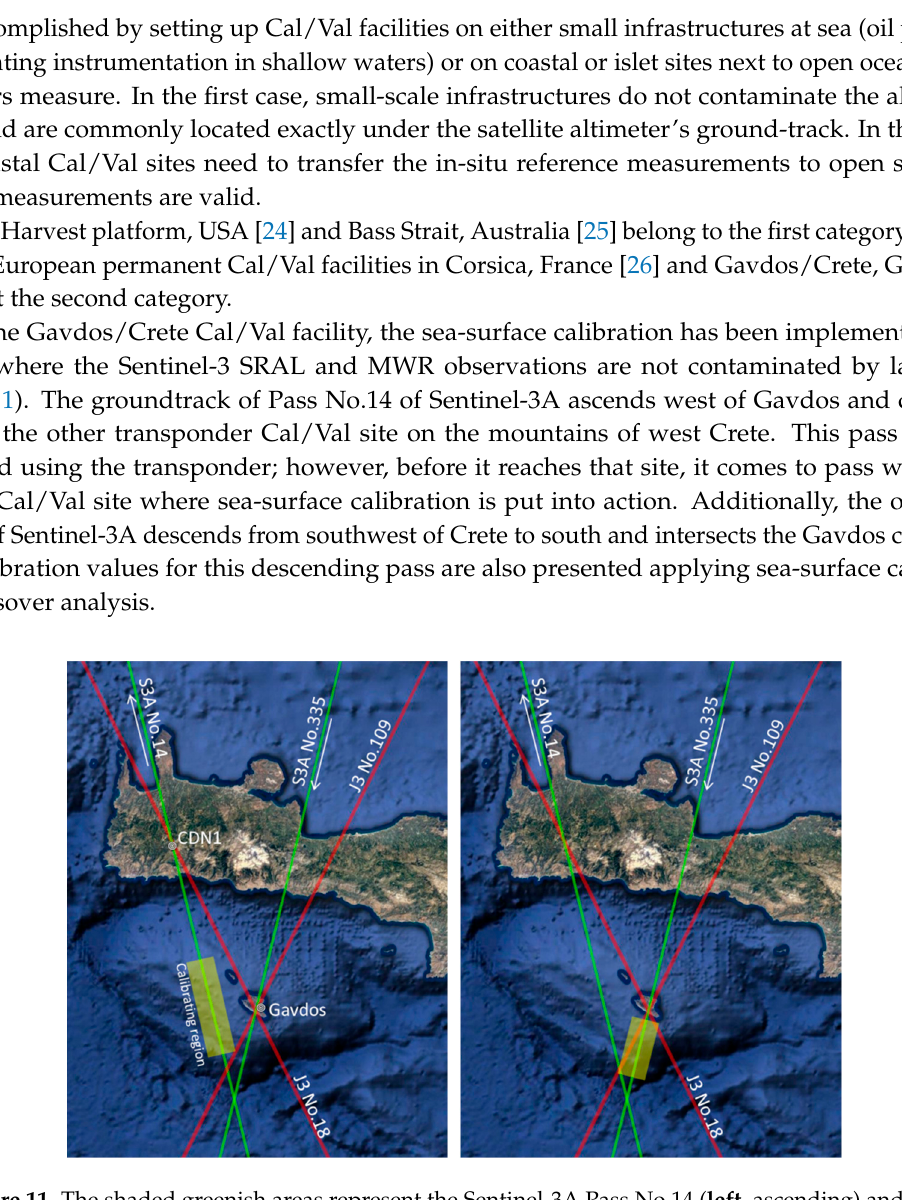
Figure 11. The shaded greenish areas represent the Sentinel-3A Pass No.14 ( left , ascending) and Pass No.335 ( right , descending) calibrating regions at the Gavdos sea-surface Cal/Val site.